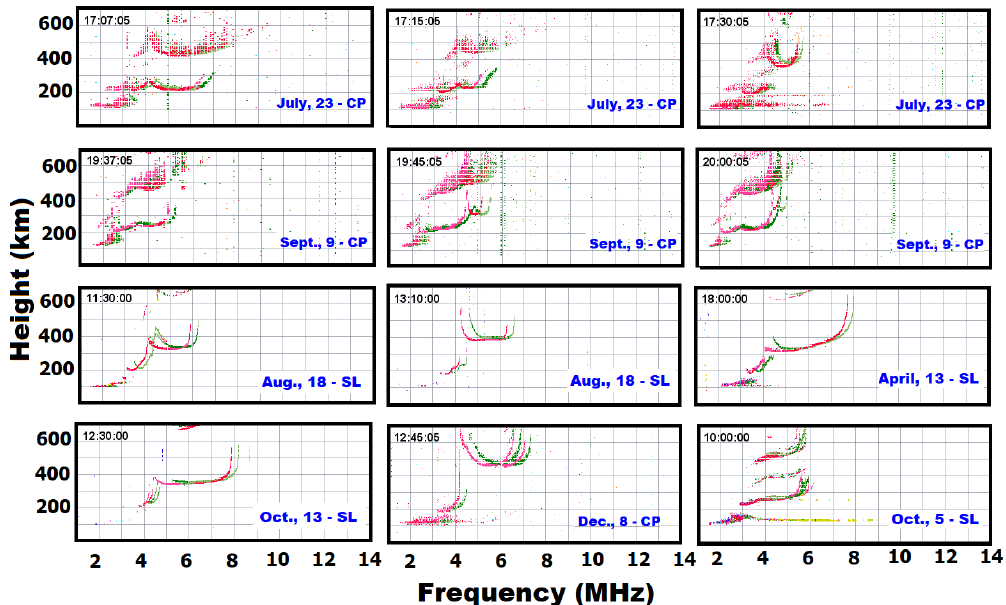
Figure 13. Ionograms showing the possible manifestation of gravity waves in the intermediate layer at equatorial (SL) and low-latitude (CP)